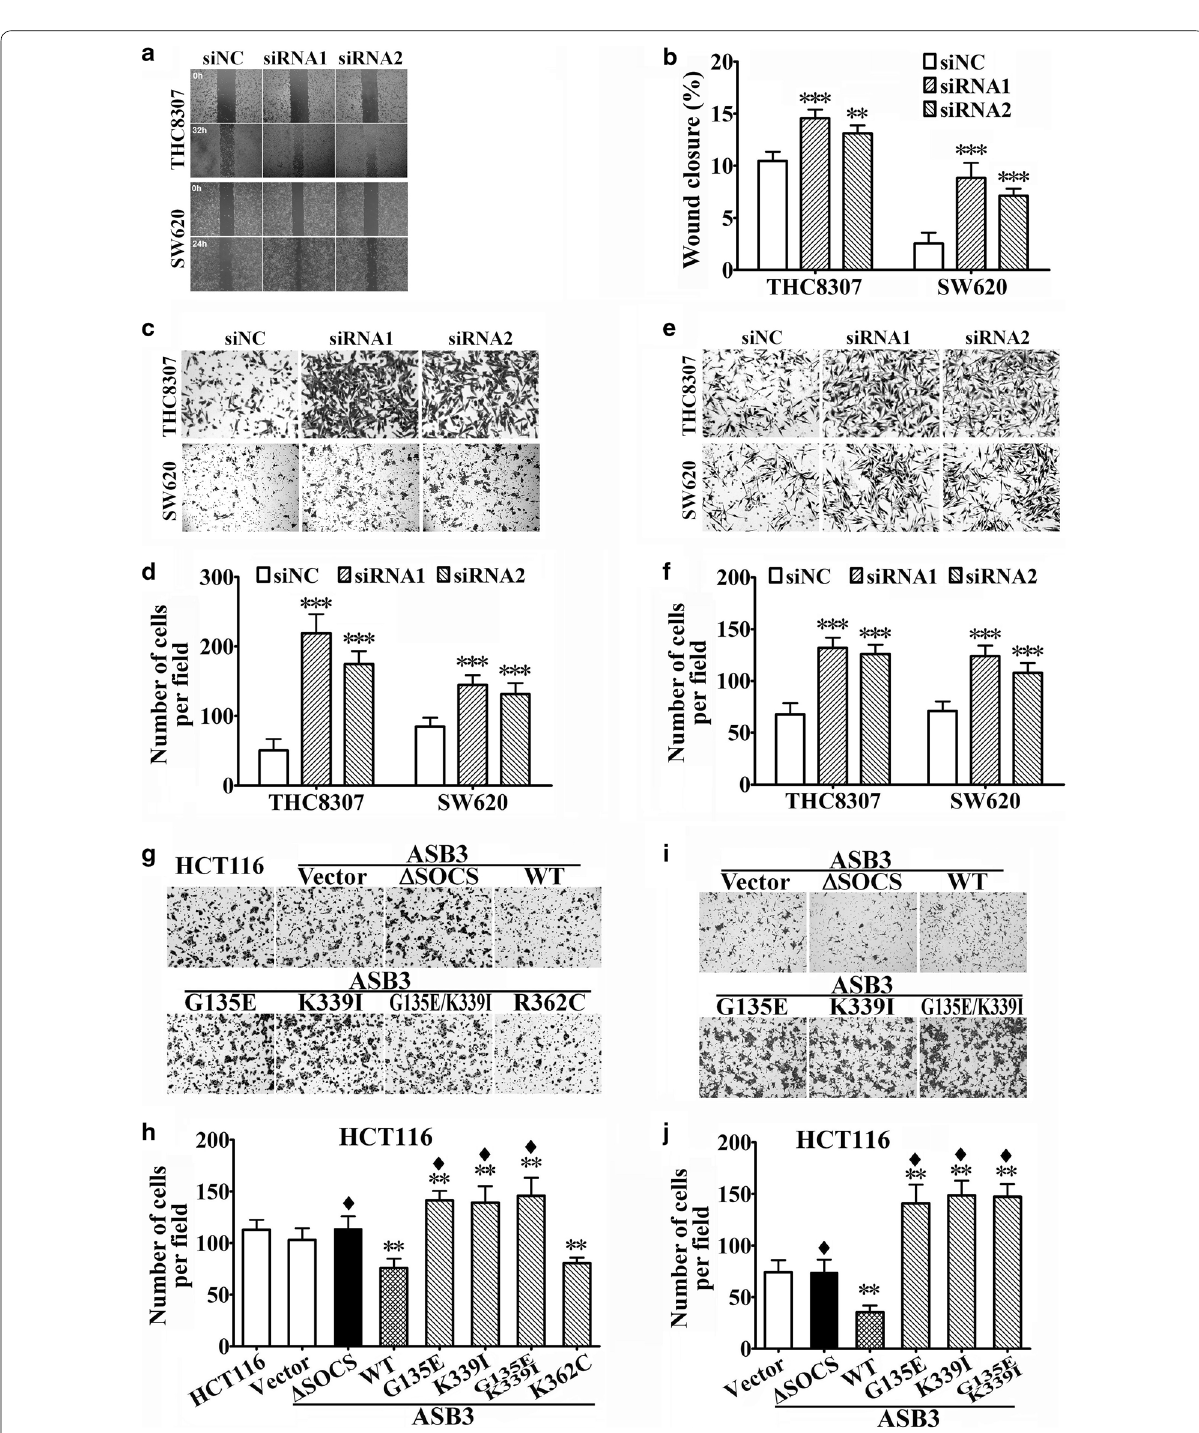
Fig. 3 ASB3 inhibits the migration and invasion of CRC cells in vitro. The migration and invasion abilities of CRC cells were detected by wound healing and transwell assays after ASB3 knockdown by transiently transfected with siRNAs or overexpression by stably transfected with ASB3 cDNA or its mutants. siNC negative control siRNA; WT wild type; G135E, K339I, R362C, and ΔSOCS are ASB3 mutants. a and b Wound healing assay, c and d transwell migration assay, and e and f invasion assay in THC8307 and SW620 cells after ASB3 knockdown. g and h transwell migration and i and j invasion assays in HCT116 cells after ASB3 (WT or mutants) overexpression. ** P < 0.01, *** P < 0.001 compared with siNC or vector control; ♦ P < 0.01 compared with that transfected with WT